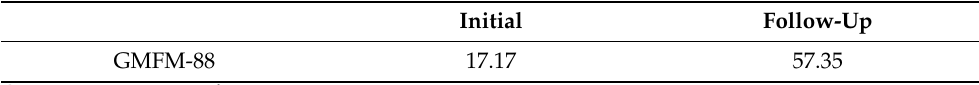
Table 2. Changes in gross motor function (unit: %).